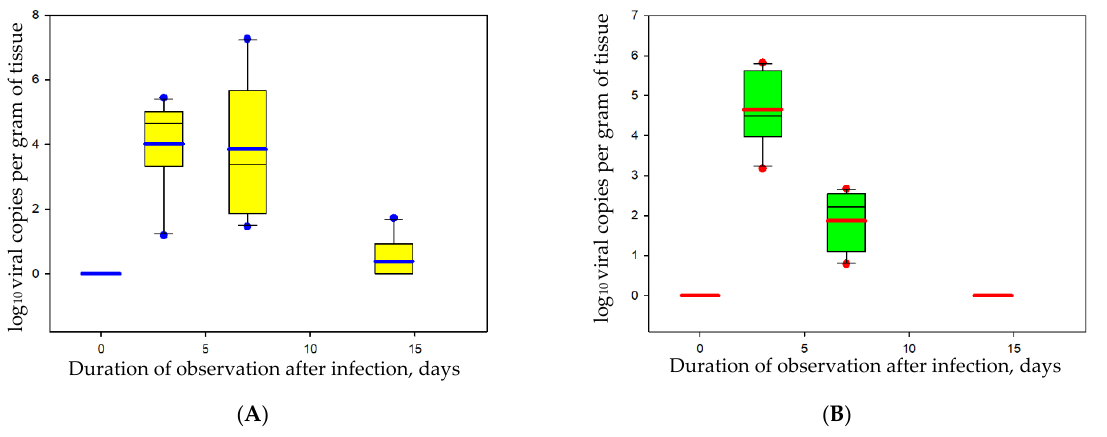
Figure 2. SARS-CoV-2 replication rate in the lungs of control ( A ) and Riamilovir ( B ) groups: ( A ) saline, 20 mL/kg, intraperitoneal, daily from 3 to 7 days after infection; ( B ) Riamilovir, 20 mg/kg, intraperitoneal, daily from 3 to 7 days after infection. Reprinted/adapted with permission (CC BY 3.0) from Ref. [76]. 2021, Chepur S.V. et al.